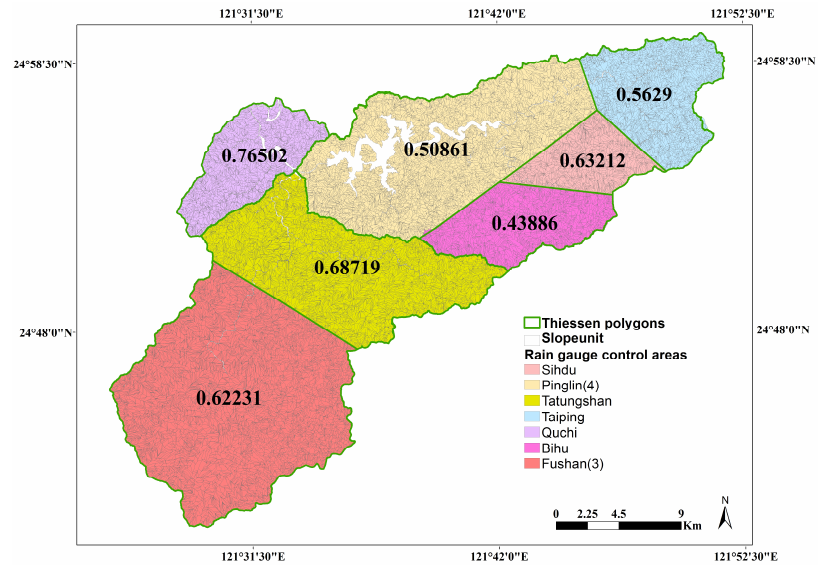
Figure 8. The exceedance probability that at least one rainfall event will exceed the threshold of discrete rainfall group within any one year in each rain gauge control area.